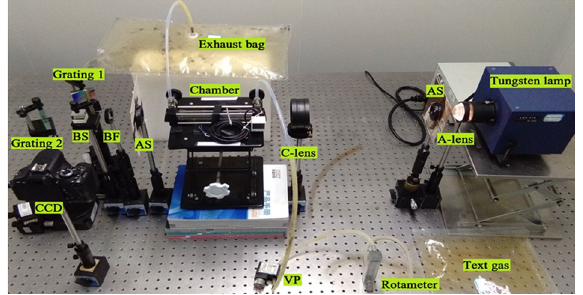
Figure 5. Experimental platform of visual gas detection system with wideband.